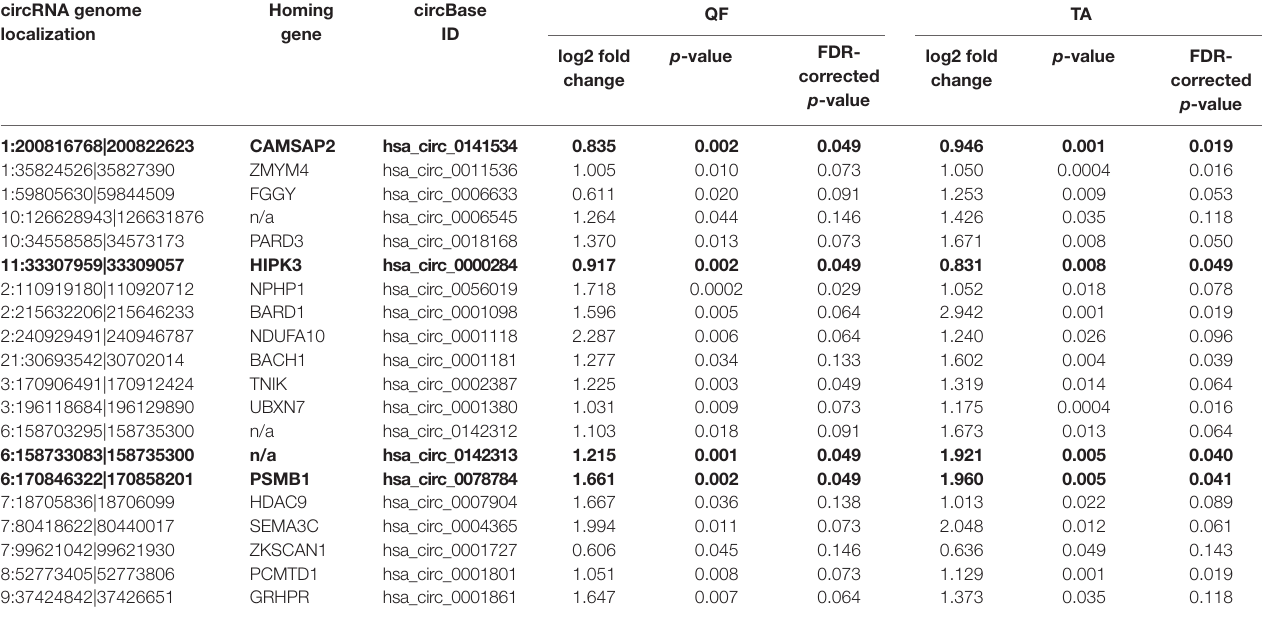
TABLE 5 | CircRNAs differentially expressed in both QF and TA